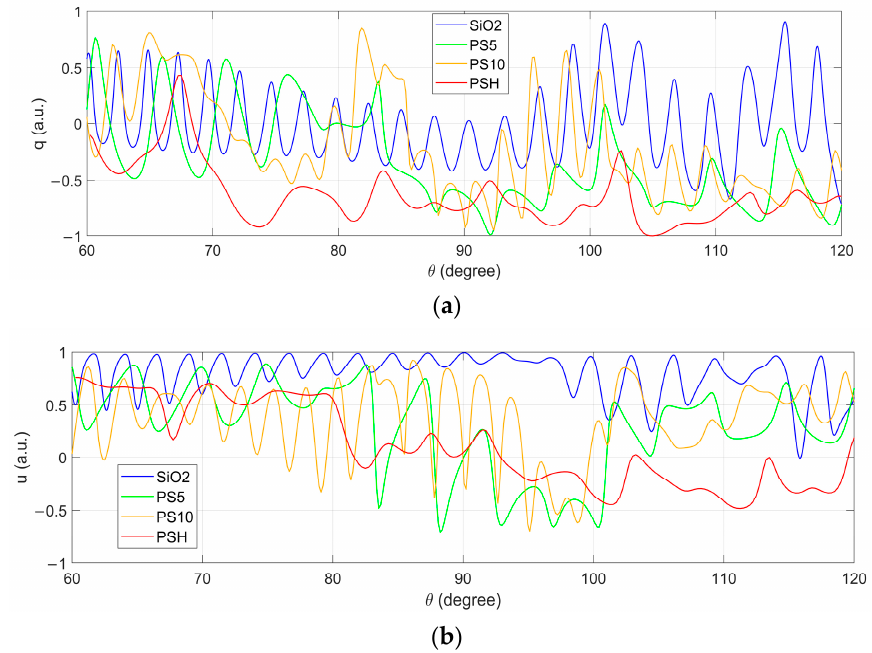
Figure 11. Simulated polarization parameters q ( a ) and u ( b ) of SiO 2 , PS5, PS10, and PSH.